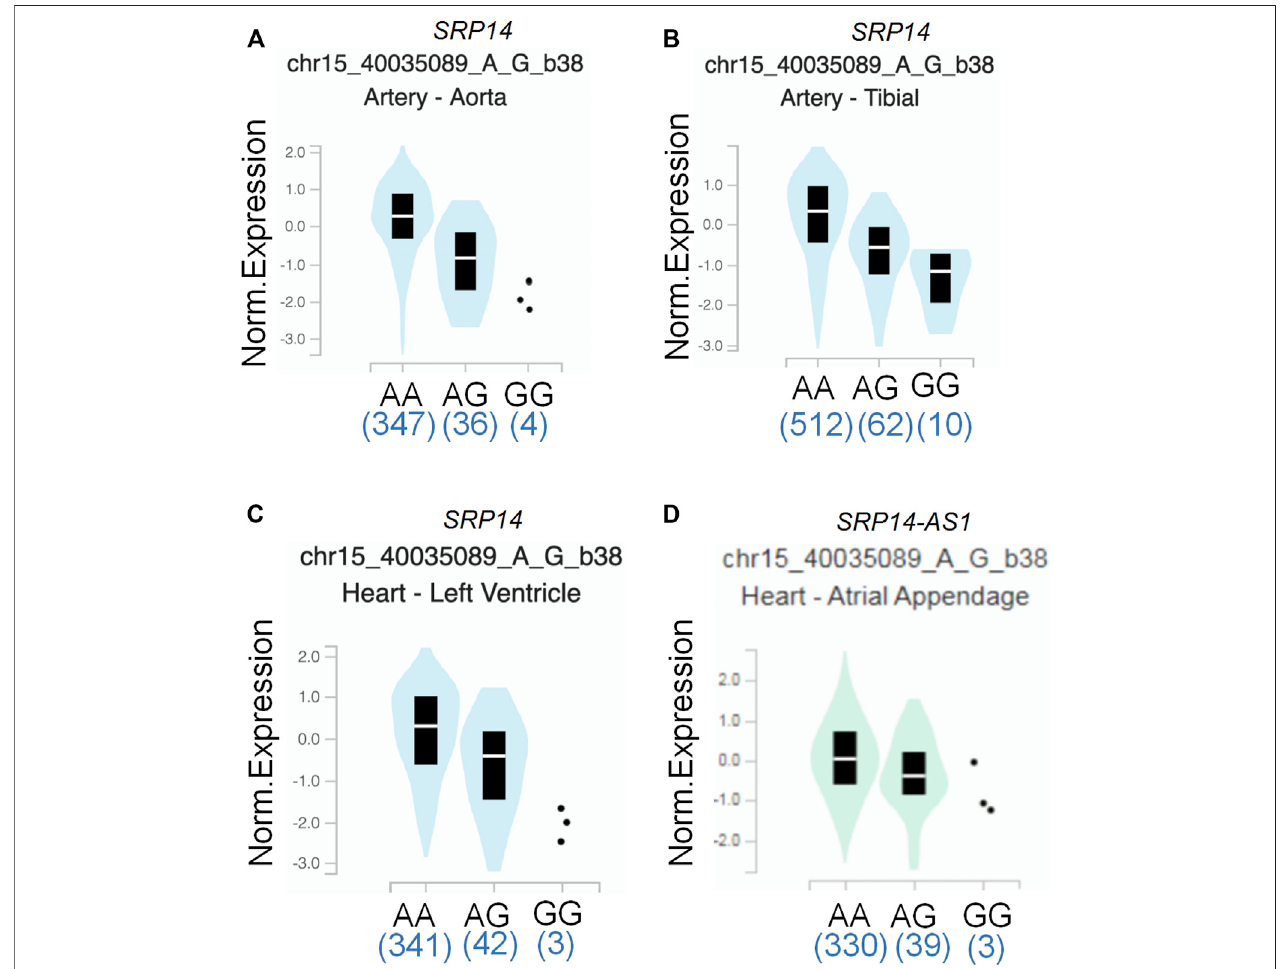
FIGURE 2 | Functional prediction of rs4594236 on a neighboring gene. (A) Correlation between rs4594236 and SRP14 gene expression in the artery of the aorta. p =6.9×10 − 10 . (B) Correlationbetweenrs4594236and SRP14 geneexpressioninthearteryofthetibia. p =2.3×10 − 9 . (C) Correlationbetweenrs4594236and SRP14 gene expression in the left ventricle of the heart. p = 3.4 × 10 − 8 . (D) Correlation between rs4594236 and SRP14-AS1 gene expression in the atrial appendage of the heart. p = 9.8 × 10 − 9 .